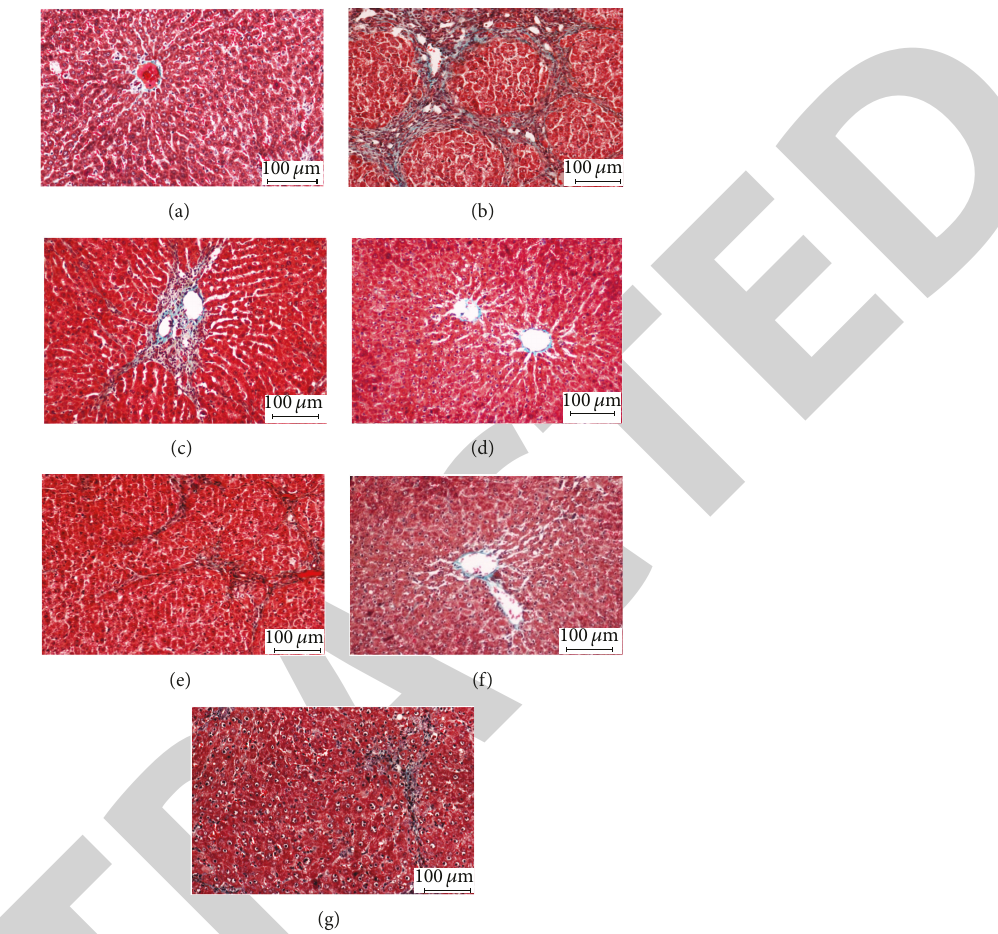
Figure 1: Photomicrographs of livers from the different experimental groups: (a) control group: showing normal liver architecture, (b) TAA group (hepatotoxic group): showing proliferation of bile duct and thick fibrous septa, (c) SY + TAA group: showing mild fibrous septa, (d) CS100 group: showing normal liver architecture, (e) CS100 + TAA group: showing multiple nodules with moderate fibrous septa and fewer cirrhotic nodules, (f) CS300 group: showing normal liver architecture, and (g) CS300 + TAA: showing mild fibrous septa. Masson’s trichrome stain (Bar scale: 100 𝜇